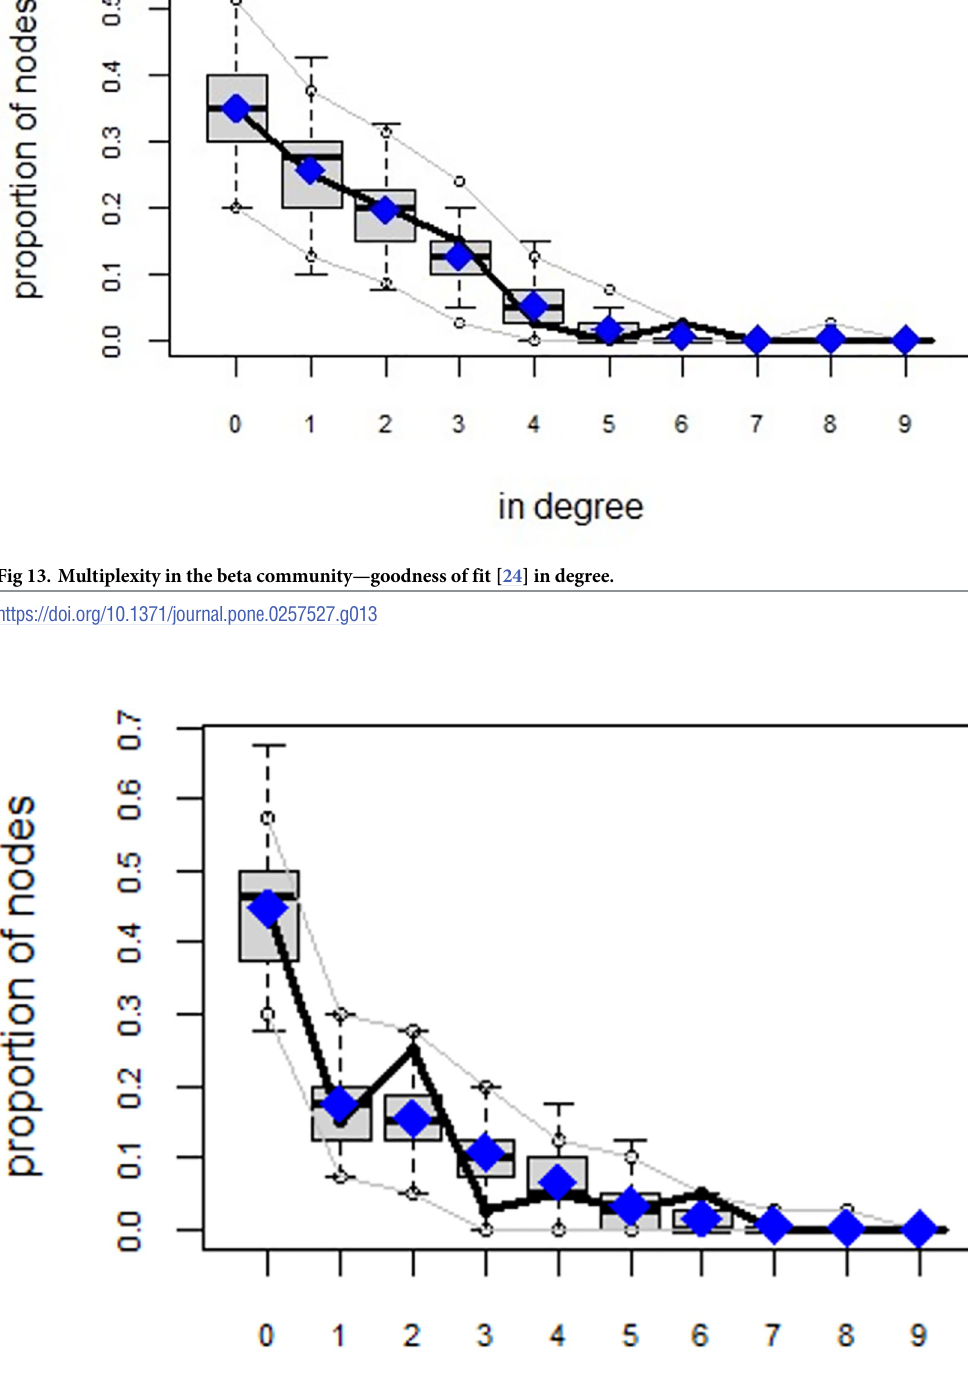
PLOS ONE | https://doi.org/10.1371/journal.pone.0257527 September 27,